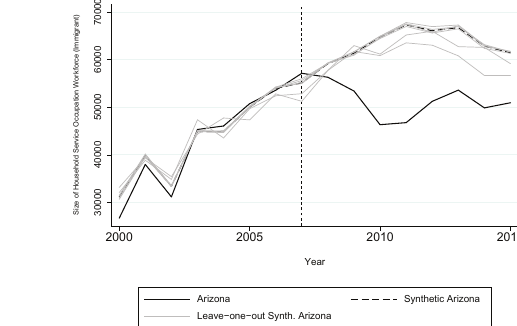
Robustness check: leave-one-out